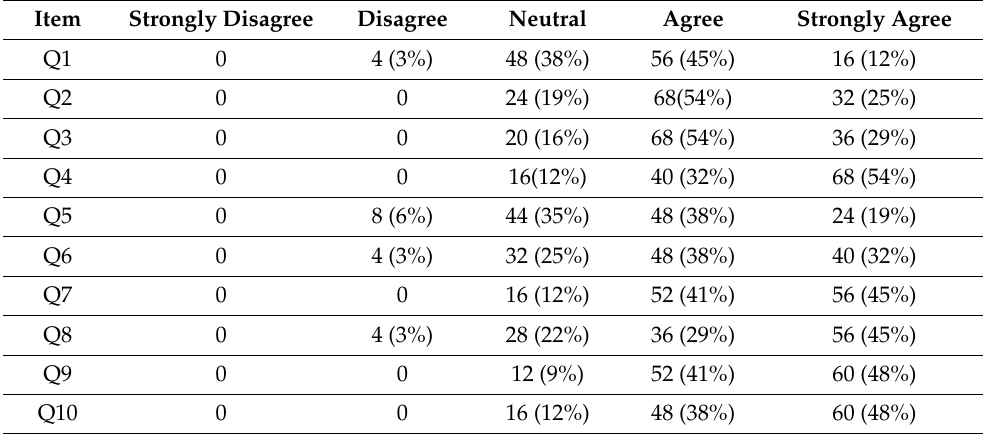
Table 15. Frequency distribution table for items regarding system